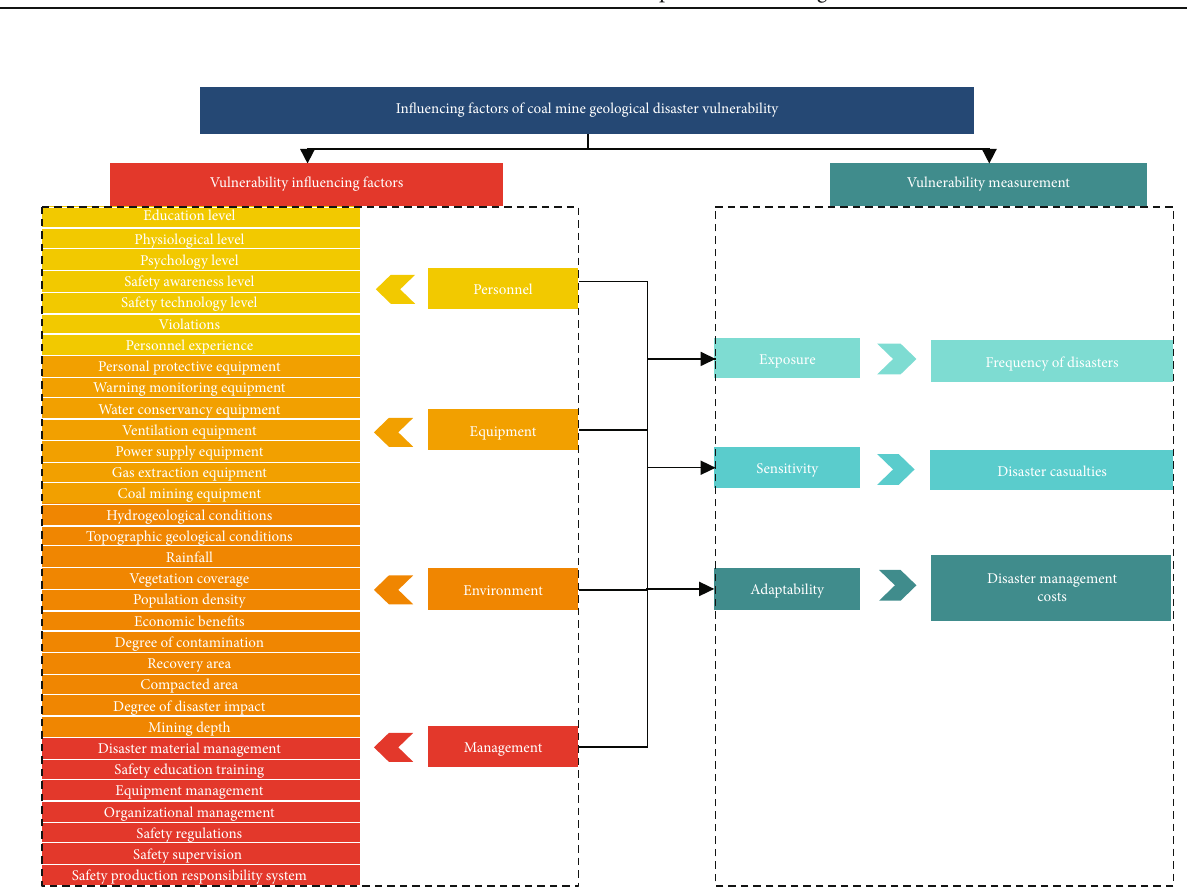
Figure 1: Theoretical model of coal mine geological disaster